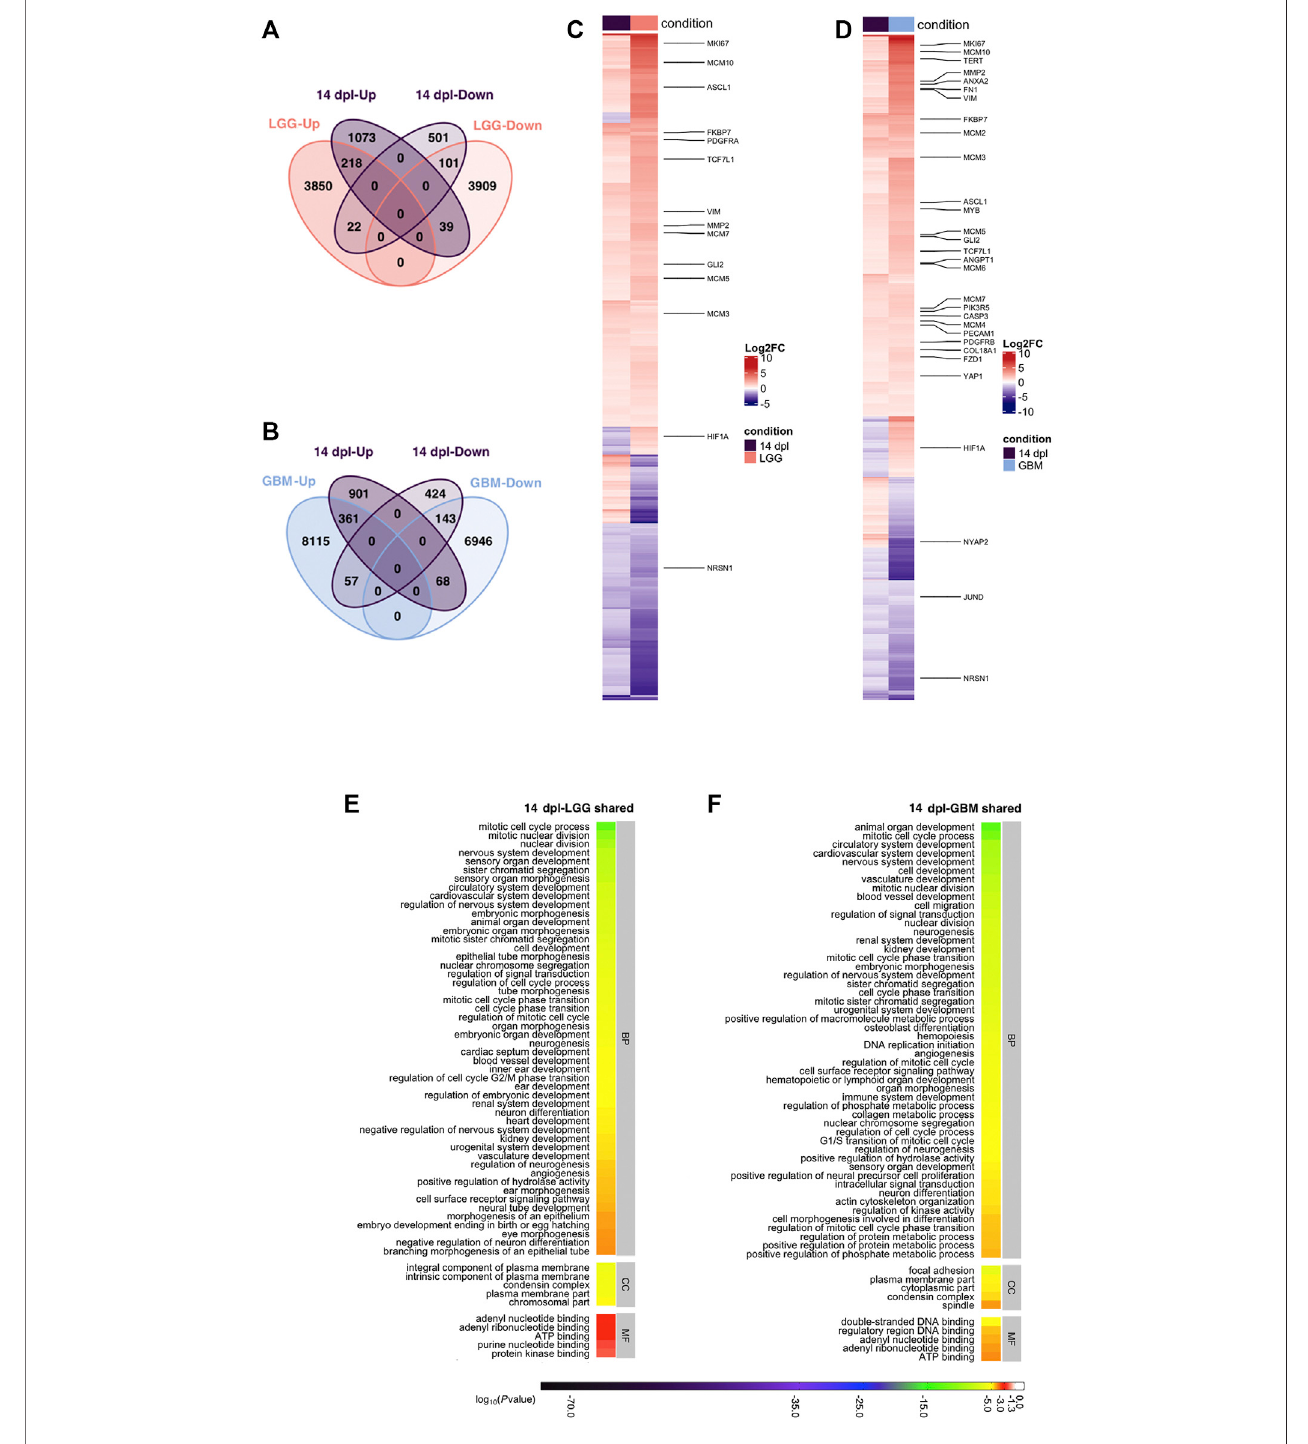
FIGURE6 | Differentiationstage (14dpl)ofbrain regenerationand braincancer share mechanisms related to developmental and morphogeneticprocesses. (A,B) Venndiagramsshowingthenumberofupregulated(Up)ordownregulated(Down)DEGsandtheoverlapbetween14dpl(purple)and (A) LGG(pink)and (B) GBM(blue). (C,D) Heatmapsshowingtheexpression ofgenesshared between14dpl(purple),and (C) LGG(pink),and (D) GBM(blue).Each columnrepresentsacondition(14dpl, LGG orGBM)and eachrow showsasinglegene.Thescalebarshowstheirlog 2 foldchangesfromhightolowregulation,representedbyacolorgradient fromred topurple,respectively. (E,F) DAVIDwasusedtoshowthemostsigni fi cantlyenrichedGO-BP(top50),CC(top5),andMF(top5)termsbasedontranscriptionalchanges in comparison of 14 dpl with (E) LGG and (F) GBM by using human identi fi ers of shared DEGs. The heatmap scale shows log 10 of the ease p -values for the most signi fi cantly enriched GO terms. dpl: days post-lesion, DAVID: database for Annotation, Visualization and Integrated Discovery, GO: Gene Ontology, BP: Biological Process, MF: Molecular Function, CC: Cellular Component, dpl: days post lesion, LGG: low-grade glioma, GBM: glioblastoma.